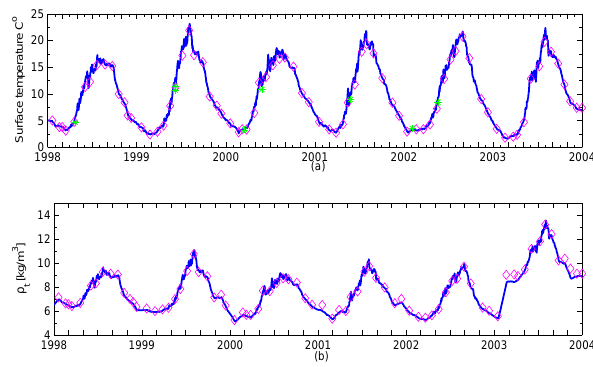
Fig. 6. Modelled (solid line) and observed (symbols): (a) – surface temperature at BS; (b) – bottom to surface density difference at